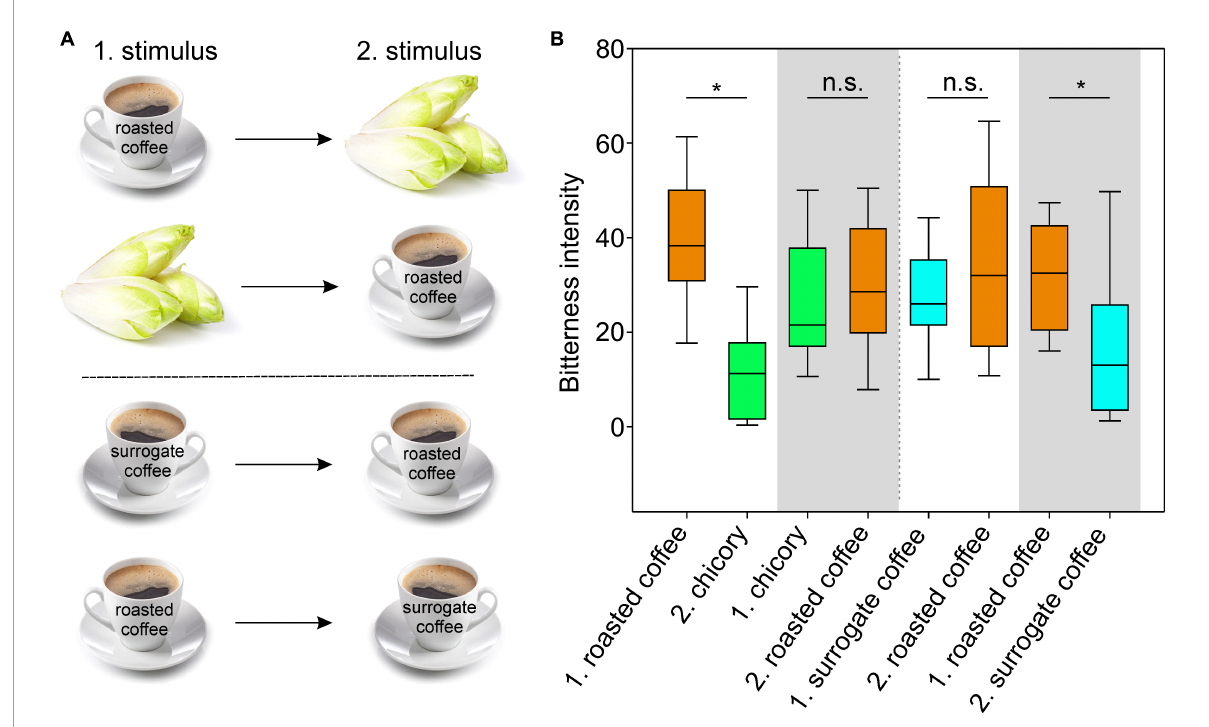
FIGURE5 Sequential testing of roasted coffee, surrogate coffee and chicory. (A) Schematic outline of the sensory experiment. (B) Graph of the experimental results of sensory tests. Volunteers rated the bitterness of roasted coffee (brown boxes), fresh chicory leaves (green boxes), and surrogate coffee (blue boxes) in sequentially offered pairs. To allow for adaptation, the first stimulus (1) was kept 30 s in the mouth before expectorating. After a brief sip of bottled water, the second stimulus (2) was evaluated. Between the stimulus pairs (indicated at the x -axis, labeled by white/gray background colors), the experiment was interrupted for 30 min to allow recovery of bitter sensitivity. Y -axis, bitterness intensity. Statistically significant influences of the first stimuli on the second stimuli are indicated by asterisks p -values (* p < 0.02; n.s. = not significant). Statistics (One-way repeated measures ANOVA with Bonferroni’s t -test) were done using SigmaPlot